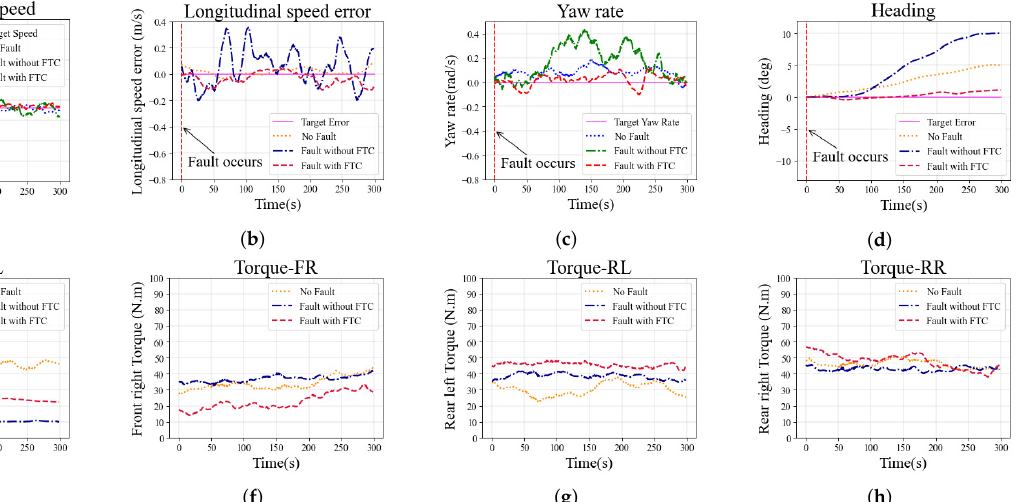
on the front left wheel: ( a ) Longi- 1